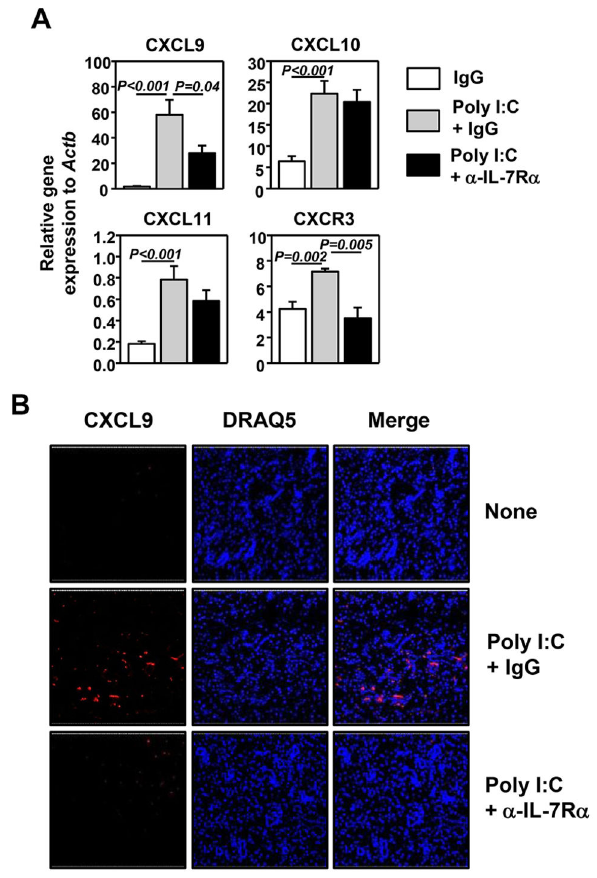
Figure 2. Poly I:C upregulates expression of CXCR3 ligands in submandibular glands in an IL-7-dependent fashion. C57BL/6 mice were pre-treated with anti-IL-7Rα 2 hours prior to poly I:C injection. (A) Levels of CXCL9, 10, 11 and CXCR3 mRNA were measured from submandibular glands 24 hours after poly I:C administration, presented relative to that of β-actin. (B) Submandibular gland sections stained with CXCL9 and DRAQ5. All data are the average of or representative of 6 individual mice (2 mice per experiment, total 3 independent experiments). doi: ligands in the submandibular glands is dependent on NK cells but not T cells. model of pSS